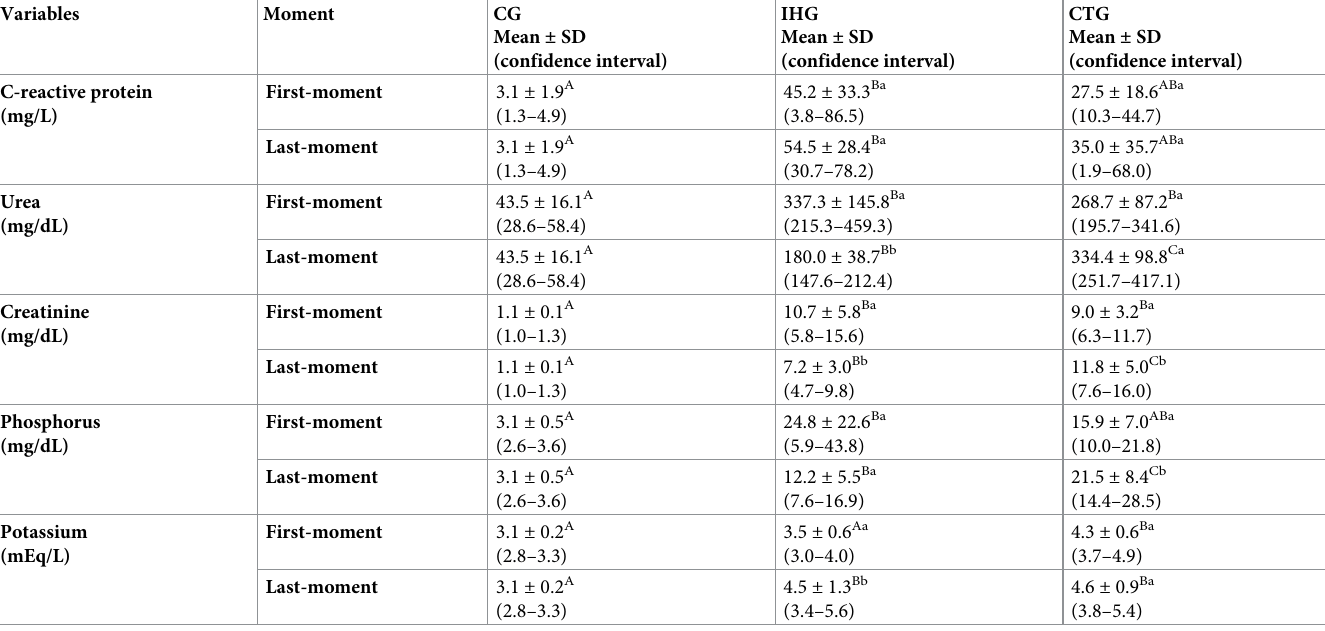
Table 1. Mean ± standard deviation (SD) and confidence interval for the concentrations of C-reactive protein (Catalyst 1 device), urea (mg/dL), creatinine (mg/dL), phosphorus (mg/dL), and potassium (mEq/L) at the first- and last-moments in dogs from CG, IHG and CTG.